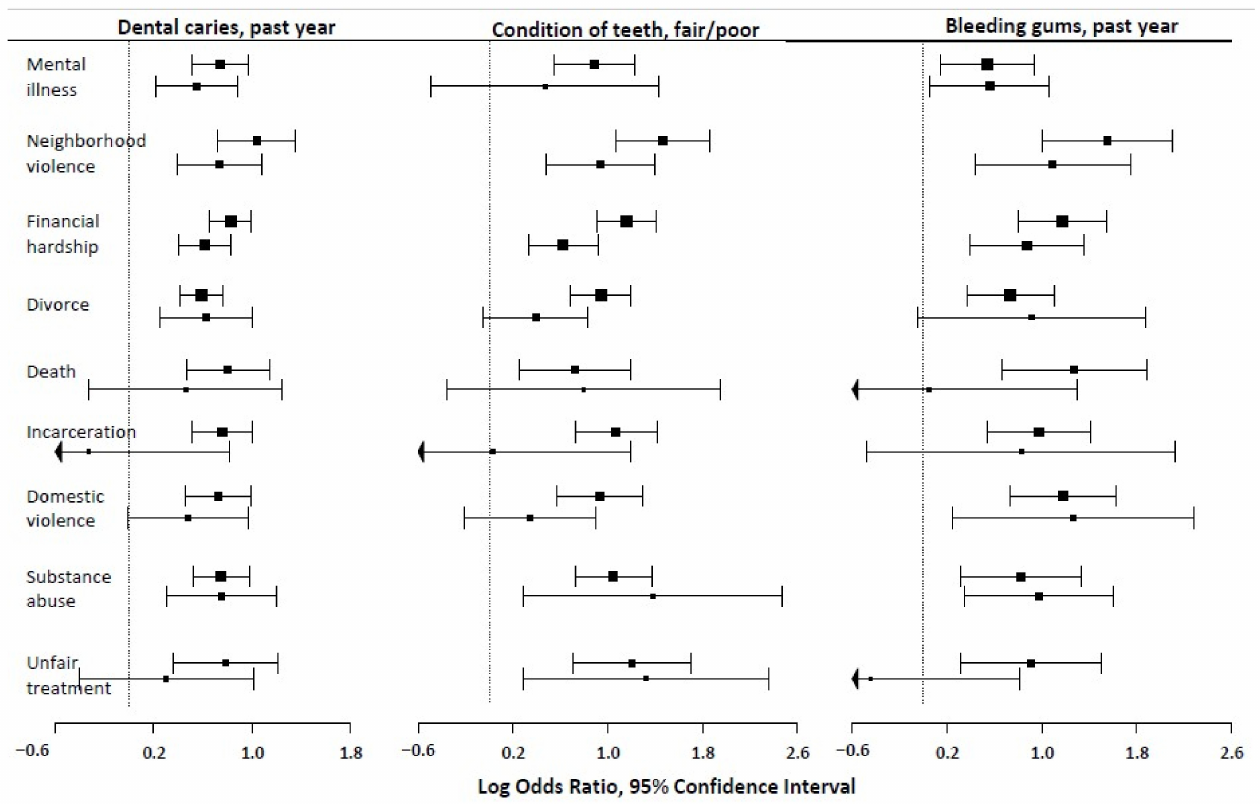
Figure 1. Unadjusted ( top ) and adjusted ( bottom ) associations between exposure to ACEs and poor oral health outcomes among children and adolescent participants of the 2016 National Survey of Children’s